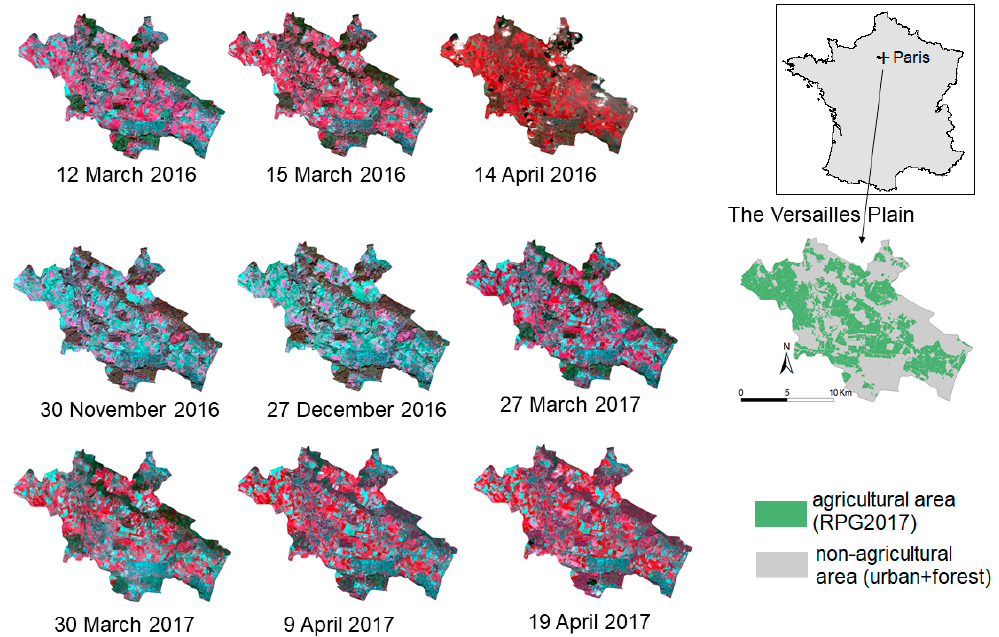
Figure 1. Agricultural area of the Versailles Plain and infrared colored images (RGB = B8, B4 and B3) of the Sentinel-2 time series gathered for this study. RPG2017 (for Registre Parcellaire Graphique ) is the Land Parcel Registry map composed of the 2017 crops declared by farmers in the framework of the European Agricultural Policy.